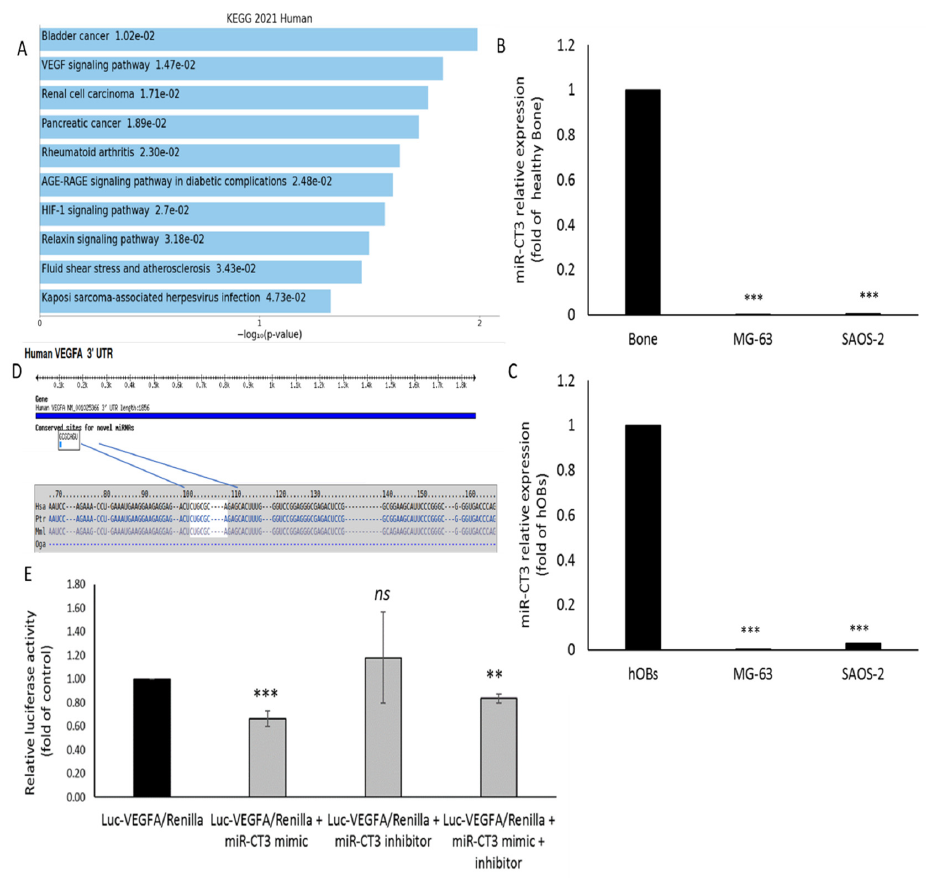
Figure 1. MiR-CT3 expression in OS cells and in silico analysis. ( A ) KEGG biological processes significantly enriched (pathways with p < 0.05) determined by Enrichr web platform ( B ) miR-CT3 expression in OS cell lines (SAOS-2 and MG-63) and human healthy bone. ( C ) miR-CT3 expression in SAOS-2, MG-63 and human primary Osteoblasts (hOBs). ( D ) Analysis output showing predicted conserved sites for miR-CT3 broadly conserved among vertebrates in 3 ′ UTR VEGF-A mRNA determined by TargetScan7. ( E ) Dual luciferase assay of Hela cells co-transfected with firefly luciferase constructs containing the 3 ′ UTR of VEGF-A and miR-CT3 mimic, miR-CT3 inhibitor or scrambled oligonucleotides (NC) as indicated. The firefly luciferase activity was normalized to renilla luciferase activity. The data are reported as relative luciferase activity of miR-CT-3- transfected cells as compared to the control (NC) of a total of 6 experiments from 3 independent transfections (Mean ± SD; ** p < 0.005; *** p < 0.0005). 2.2. The Enforced Expression of miR-CT3 Down-Regulates VEGF-A To assess whether miR-CT3 directly affects the expression of VEGF-A in OS cells, we evaluated the effect induced by enforced expression of synthetic miR-CT3 mimics on VEGF-A protein and mRNA levels. Firstly, the transfection efficiency of miR-CT3 was measured by qRT–PCR 24 h after treatment in SAOS-2 and MG-63 cells (Supplementary Figure S1). In addition, it was observed that the enforced expression of synthetic miR-CT3 mimics reduced the expression of VEGF-A mRNA and the secretion of VEGF-A protein (Figure 2A,B). Then, the expression of the angiogenic factor IL-8 by qRT-PCR and of the metalloproteinase MMP9 by both qRT-PCR and Elisa assay were also evaluated (Figure 2A,C).